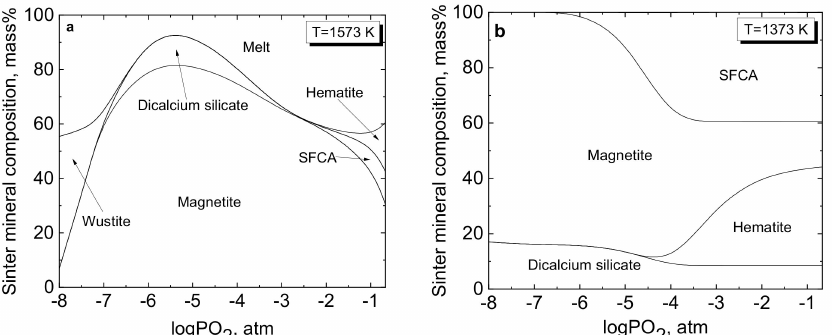
Figure 7. Mineral composition of sinter under varied oxygen partial pressure at temperature of ( a ) 1573 K and ( b ) 1373 K.